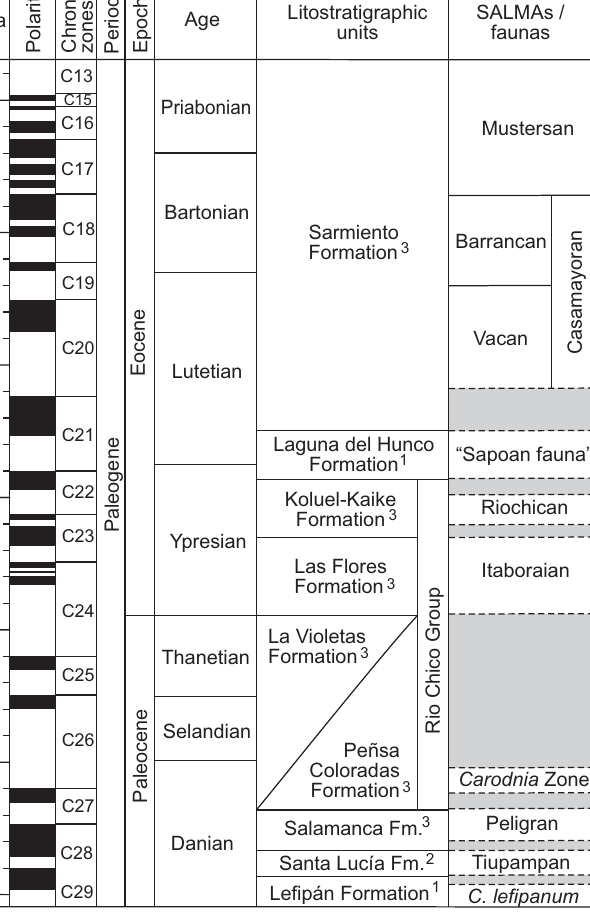
Fig. 2. Geochronology of SALMAs and litostratigraphic units